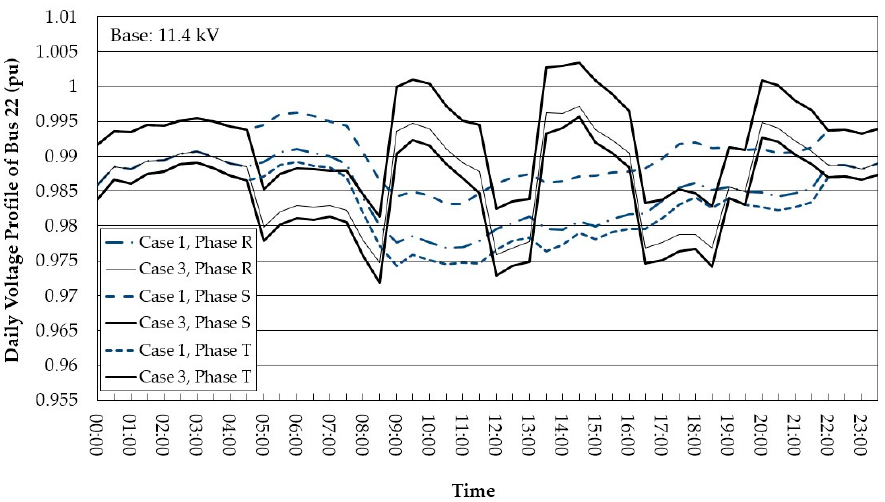
Figure 16. Voltage variation comparison on Bus 1 for Case 1 and Case 3.